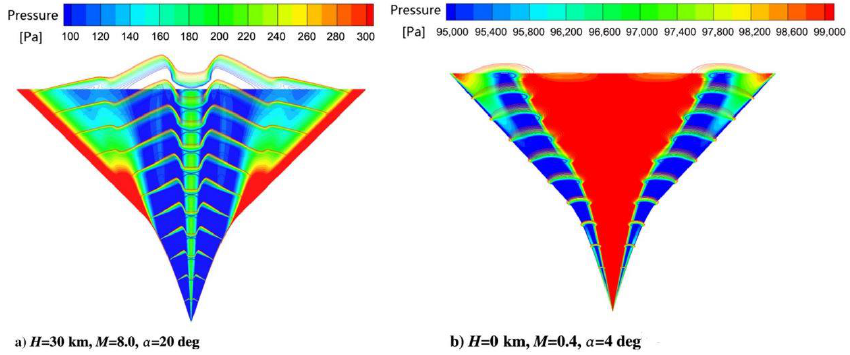
Figure 8. Pressure distribution on the upper surface of the double-swept waverider [21].